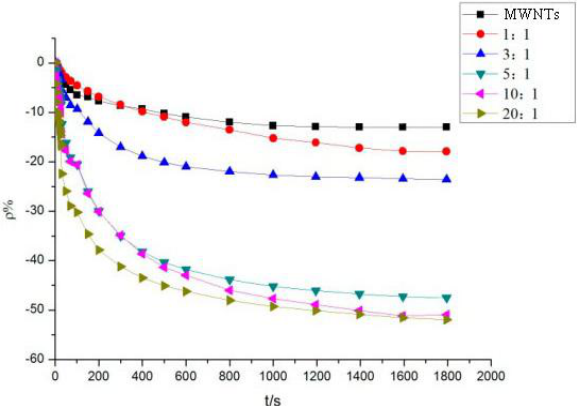
Figure 6. MWNT sensor response to H